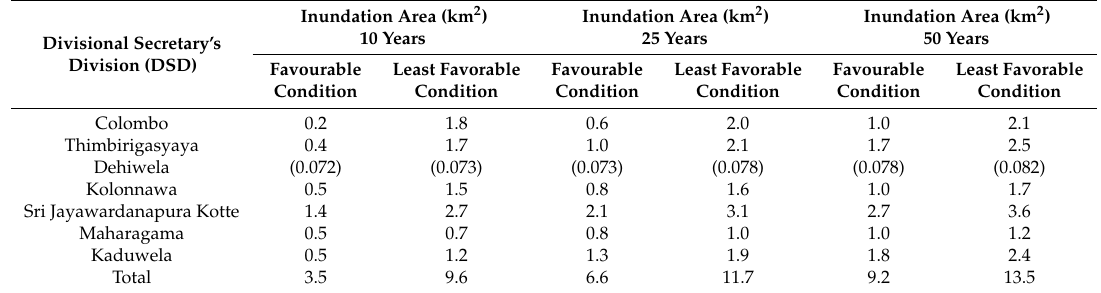
Table 3. Comparison of inundation areas for design rainfalls under favourable and worse conditions.